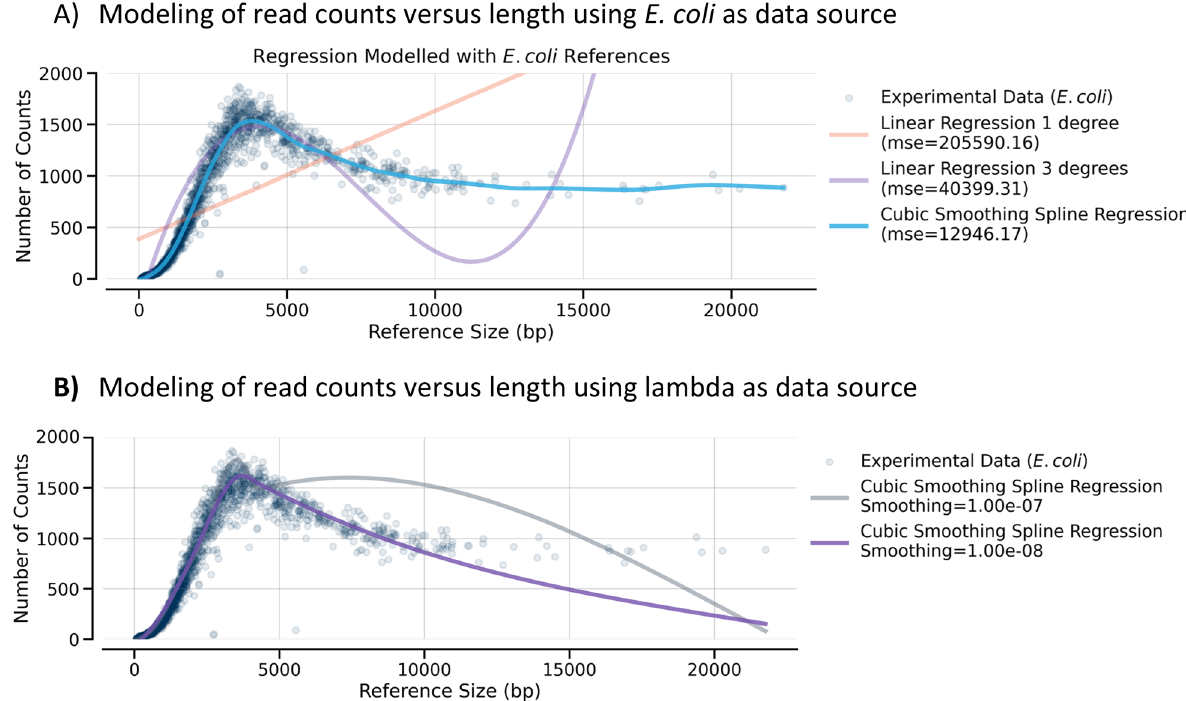
Figure 9. Fitting of DNA length versus read frequency. The read frequency of DNA fragments was fit using linear regression and cubic spline regression with E. coli DNA read counts as a data source ( A ). E. coli and lambda DNAs were mixed, cut with PvuII, and prepared using the 2.1 PacBio protocol. Because the linear regression methods did not model the E. coli DNA well, only cubic smoothing spline regression was used for lambda DNA. Lambda DNA was then used as the data source ( B ) and the spline regression generated with lambda data only was compared to the experimentally observed data for E. coli lengths and read counts. The darker blue line provides the best fit for both the modelled lambda and the experimental E. coli